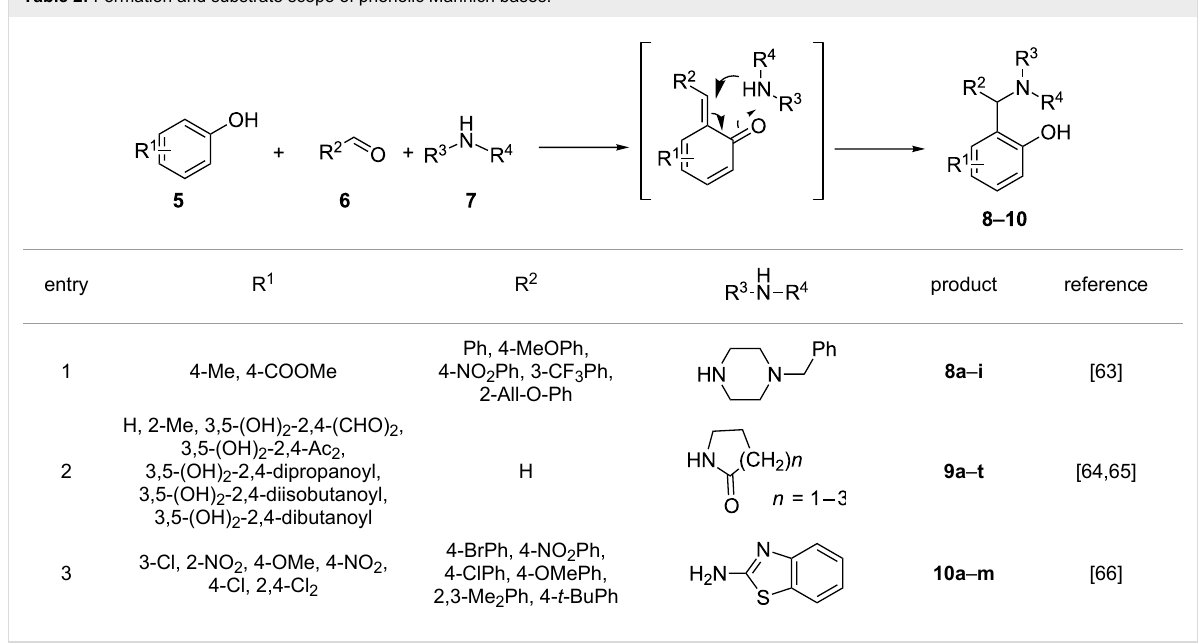
Table 2: Formation and substrate scope of phenolic Mannich